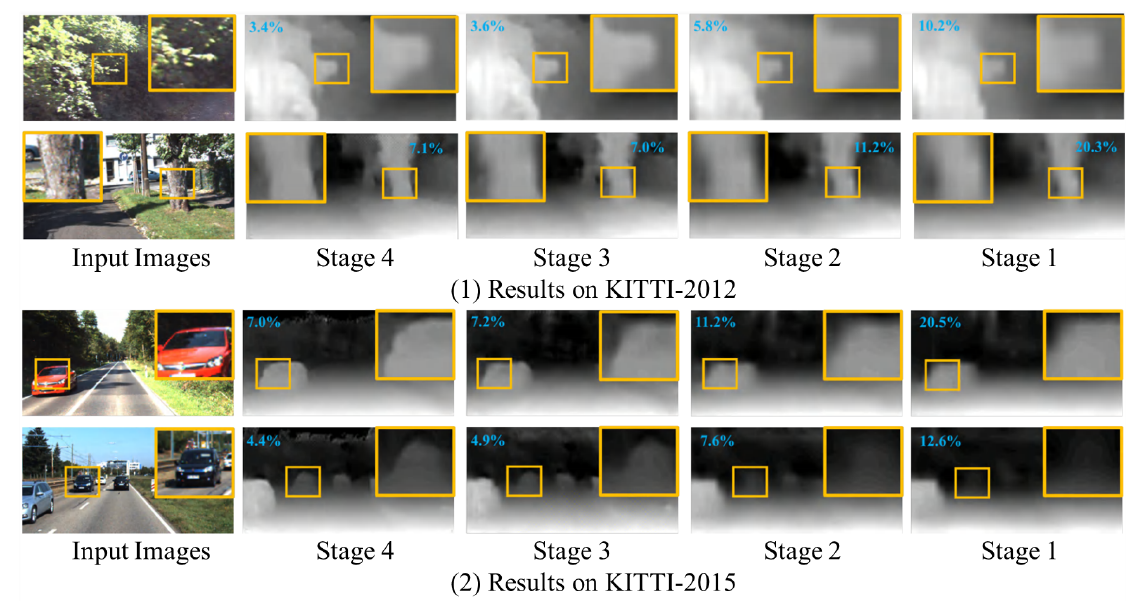
Figure 3. Disparity predictions using ProjACQN from four stages of AnyNet under 70% energy cost on KITTI-2012 and KITTI-2015. Three-pixel errors are shown as red numbers, the lower the better.